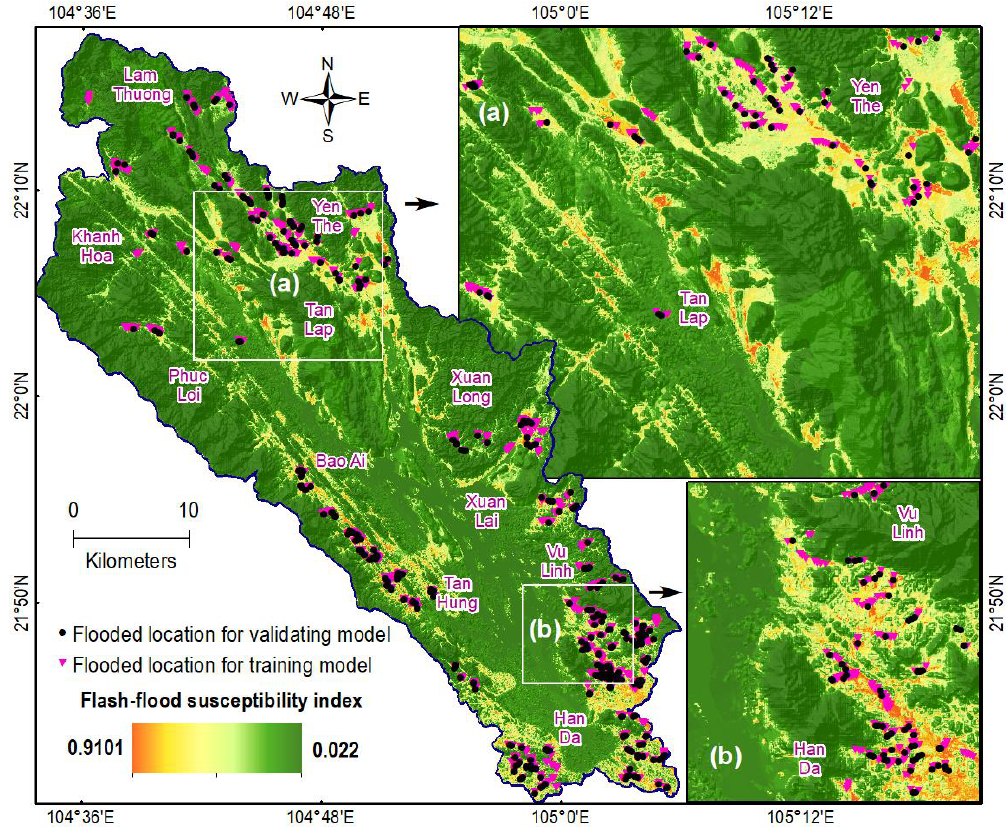
Figure 8. Flash flood map for the Luc Yen area using the CHAID-RS-BBO model.